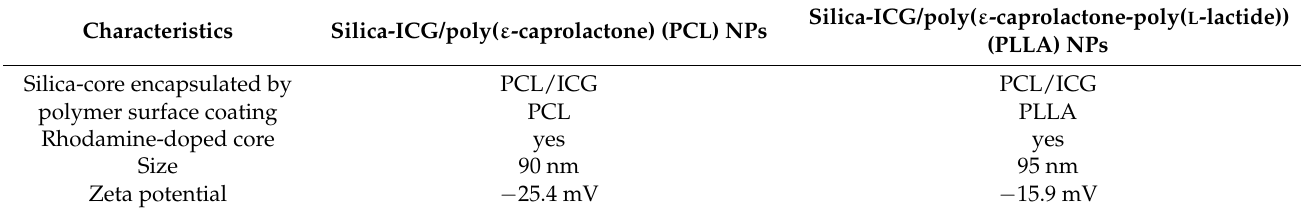
Table 1. Physicochemical characteristics nanoparticles